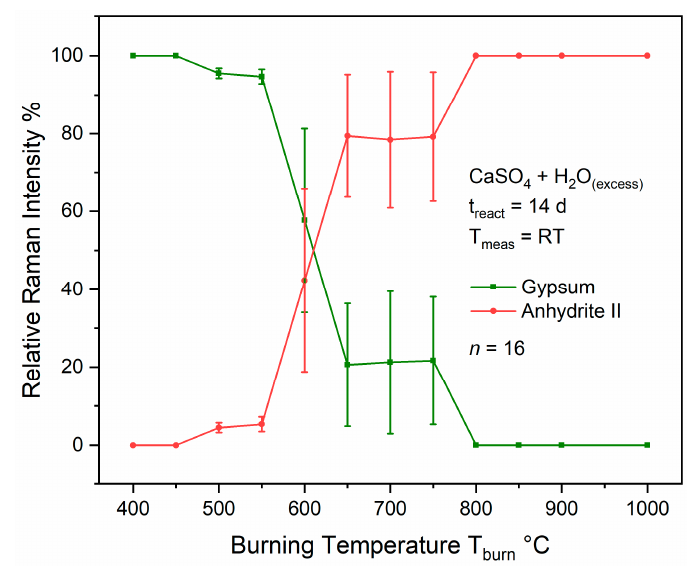
Figure 19. Reactivity test of the anhydrite II samples synthesised in crucibles mentioned in Figure 18. Anhydrite was exposed to an approximate three-fold excess of water for 14 days, and relative Raman intensities assigned to gypsum and anhydrite II were determined at 16 sample spots as measures for the compositions of the end products.